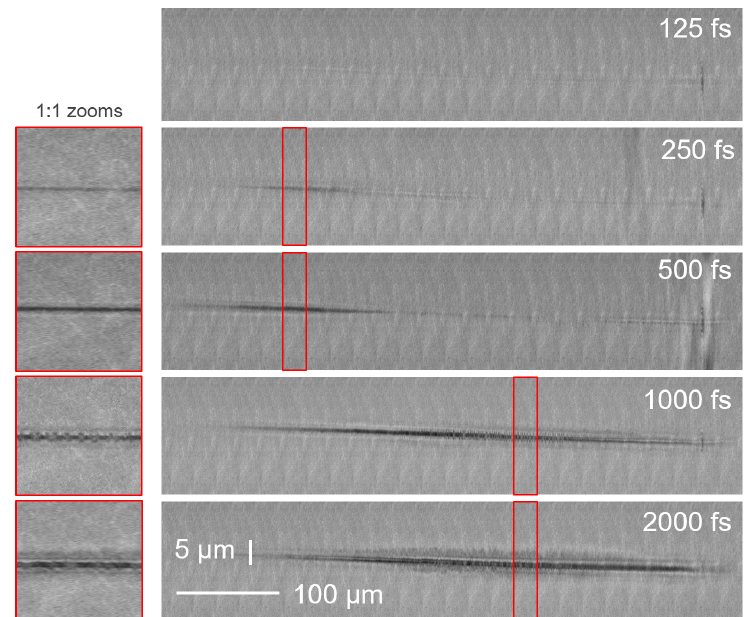
Figure 3. Microscope images of damages produced in fused silica glass for several pulse durations, for same beam position inside sample and for a constant single shot energy of 52 µ J. Please note image aspect ratios (left insets show 1:1 zooms of panels to their right). Beam propagates from left to